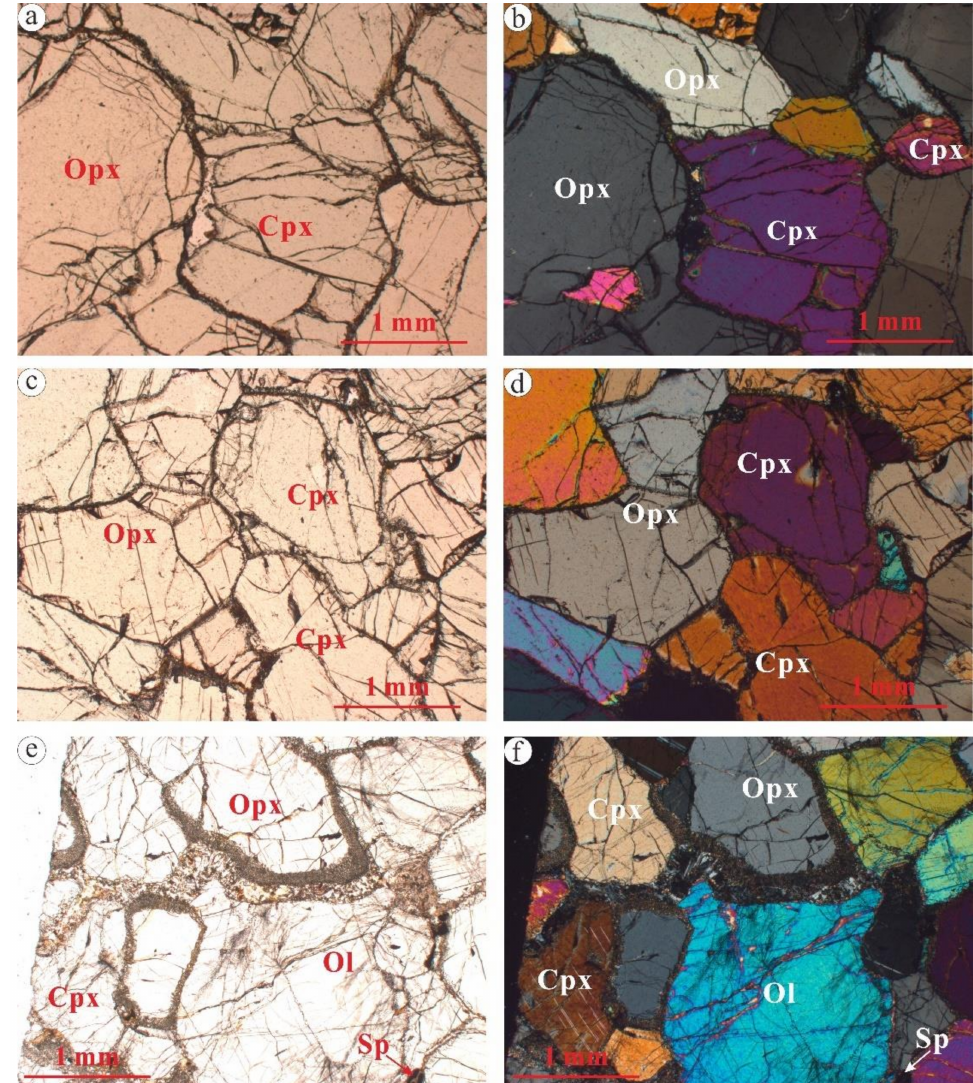
Figure 3. Photomicrographs of the websterite xenoliths from Hannuoba, with the plane-polarized ( a , c , e ) and cross-polarized light ( b , d , f ), respectively, showing the mineral assemblage of olivine + orthopyroxene + clinopyroxene + Sp. Abbreviations: Cpx: clinopyroxenite; Opx: orthopyroxene; Ol: olivine; Sp: